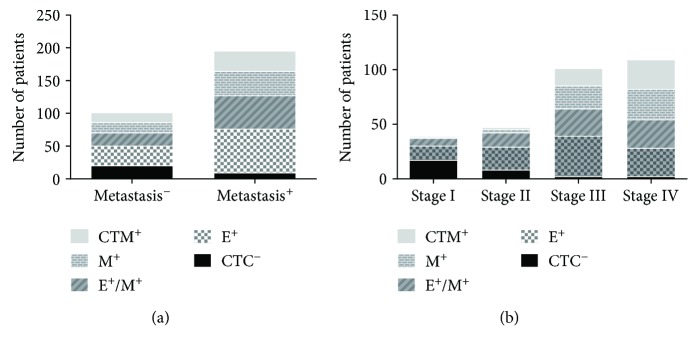
Distribution of CTC subpopulations in patients with CRC. (a) Distribution of CTC subpopulations in patients with or without metastasis. (b) Distribution of CTC subpopulations in patients at different stages of CRC. CTC, circulating tumor cell; CRC, colorectal cancer.